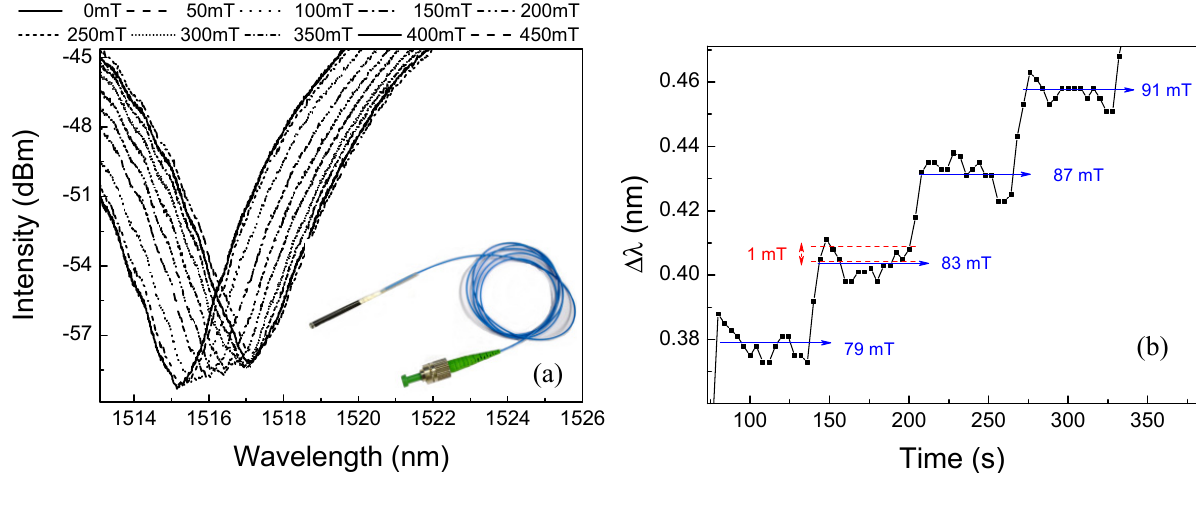
Figure 2. ( a ) Interferogram measured by the optical interrogator. Inset shows photo of the fabricated sensor head; ( b ) Magnetic field sensor